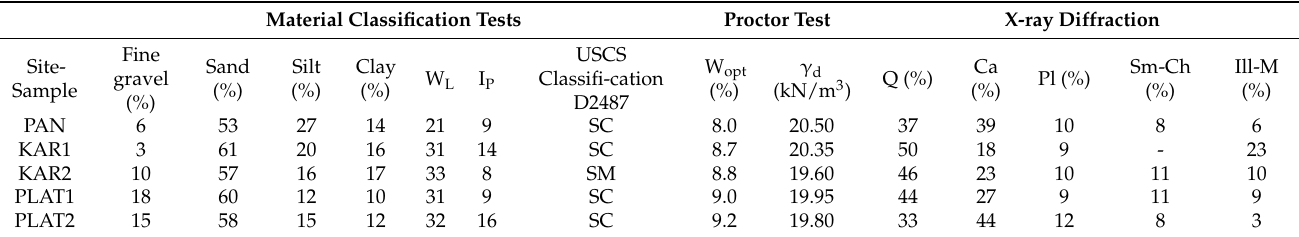
Table 3. Summary of the physical and mineralogical characteristics of the flysch material. Material Classification